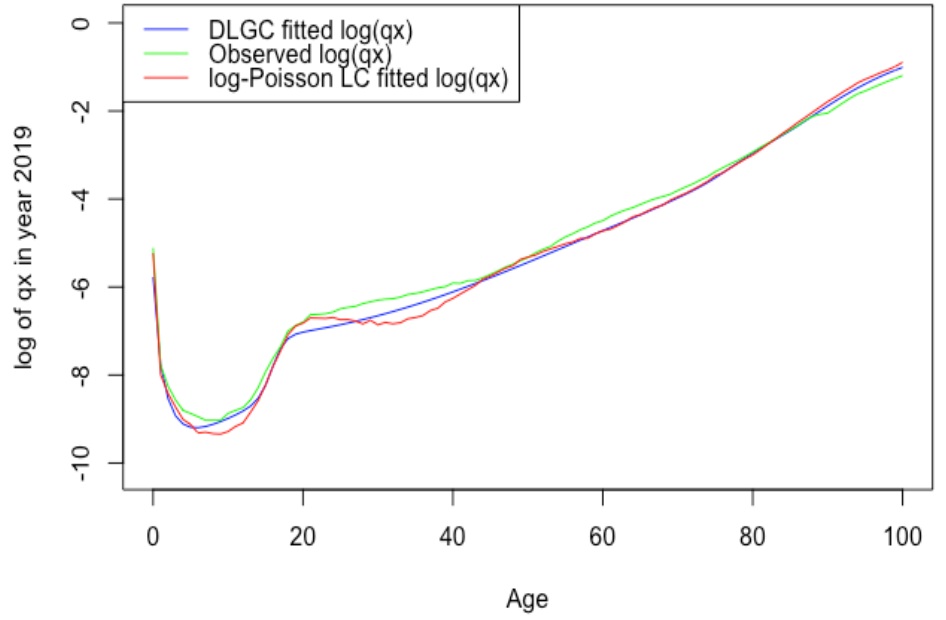
Figure 2. USA male 2019 death rate forecasting log value of DLGC and the logit-binomial Lee- Carter